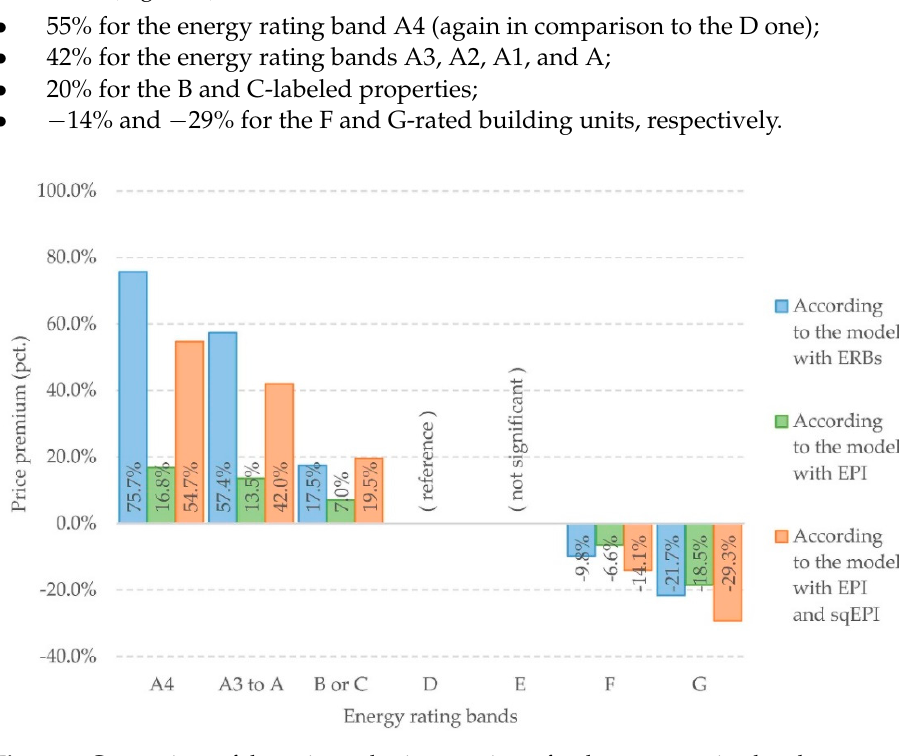
Figure 7. Comparison of the estimated price premiums for the energy rating bands. Table 3. Results for the spatial autoregressive model with the quadratic term of EPI. Model for EPI and sqEPI Coeff. Std.